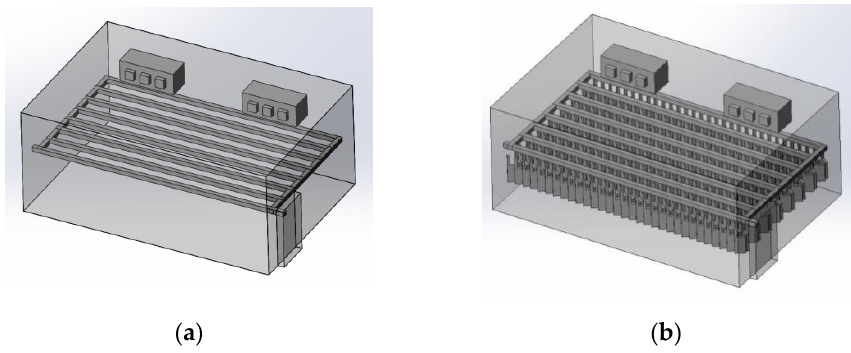
Figure 1. 3D model of chiller and pig carcass after cooling for 0 h ( a ) and 8 h ( b ).